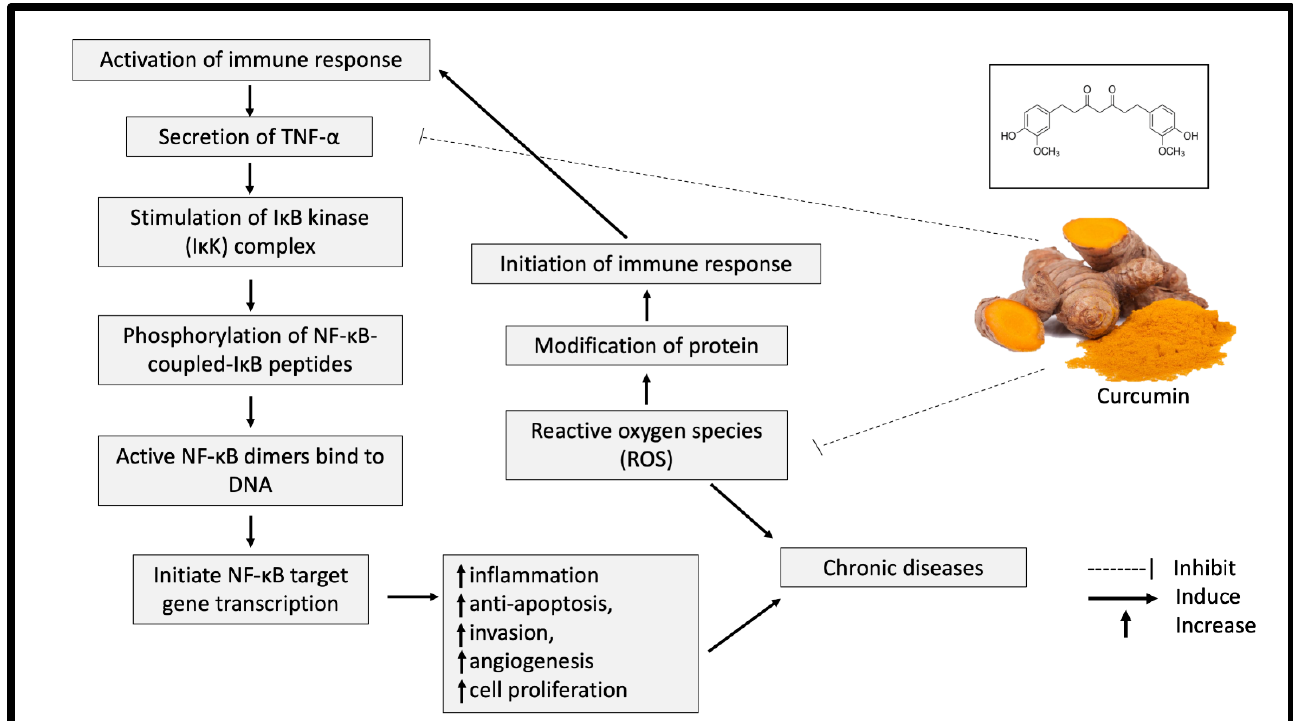
Figure 2. Potential inhibitory effect of curcumin on inflammation and oxidative stress. TNF- α : tumor necrosis factor alpha; NF- κB : nuclear factor kappa B; IKK: IκB kinase .